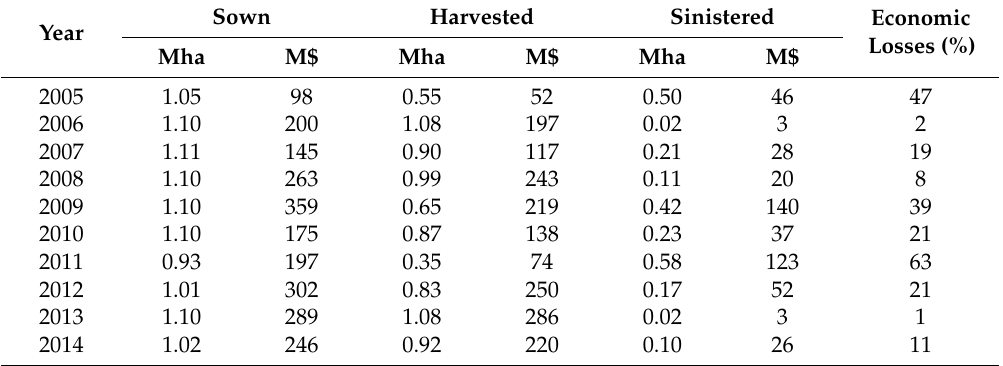
Table 3. Comparison between drought severity and agricultural economic